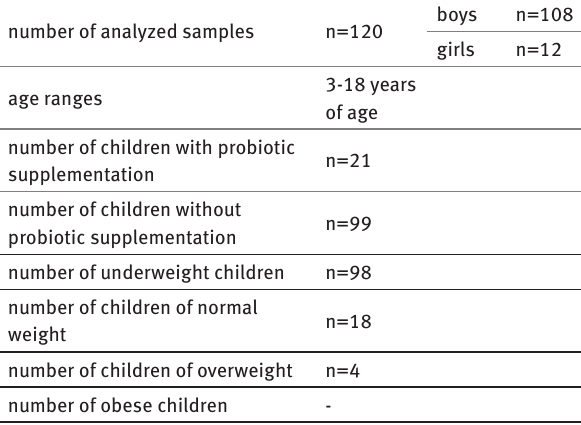
Table 4 Stratification of the tested population number of analyzed